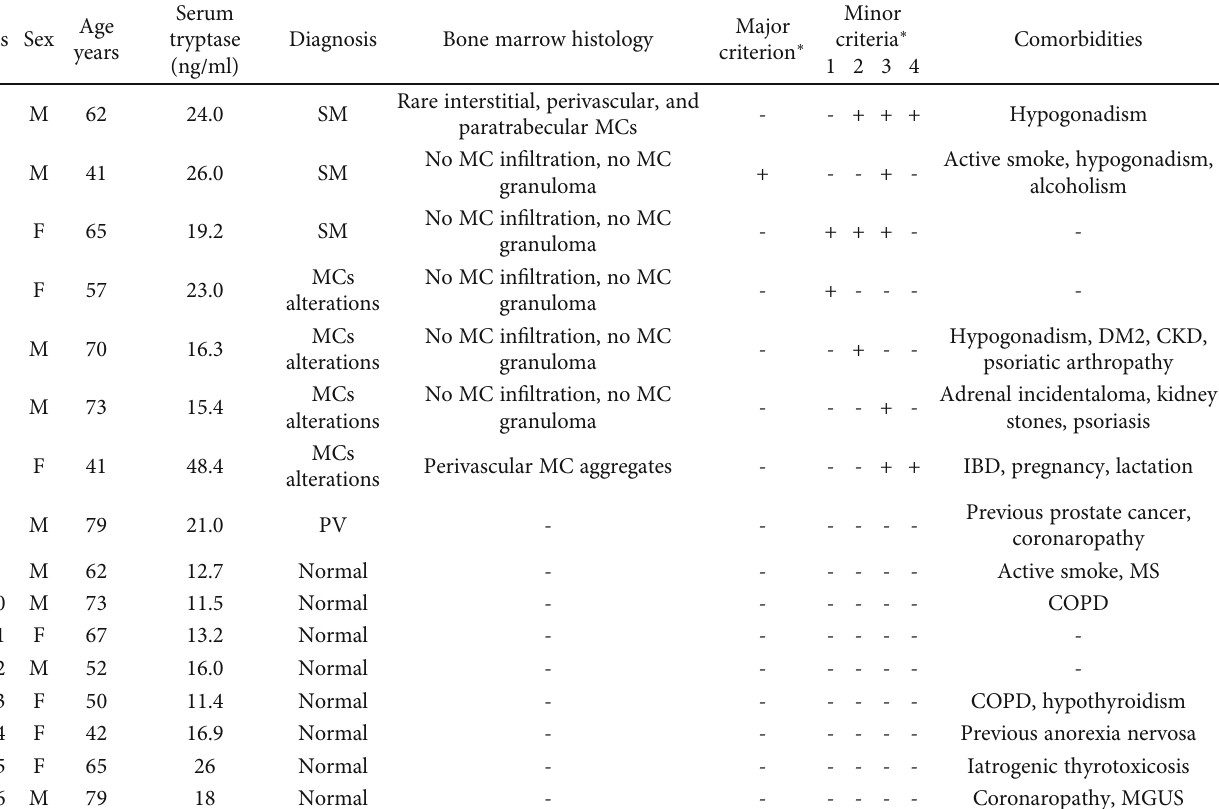
Table 1: Bone marrow assessment and clinical fi ndings in osteoporotic patients with